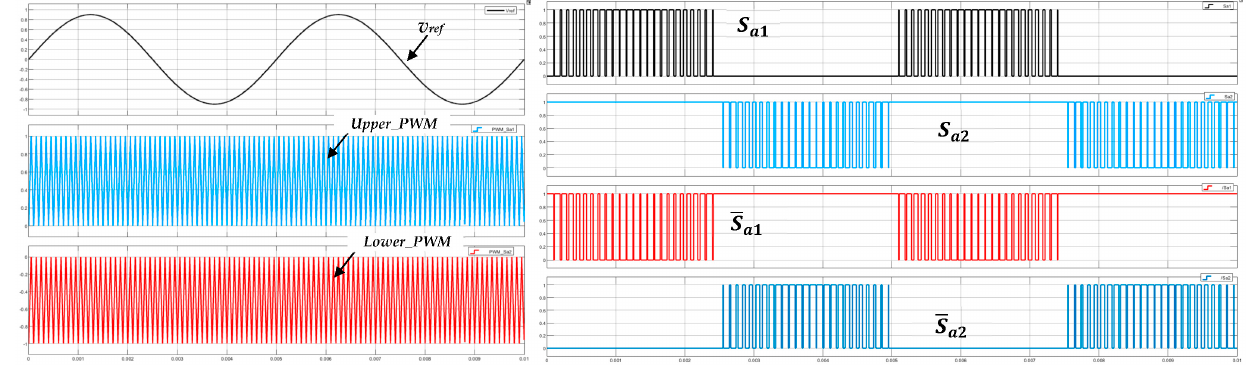
Figure 9. NPC-waveforms of the per-unit reference voltage, PWM carriers, and switching signals.